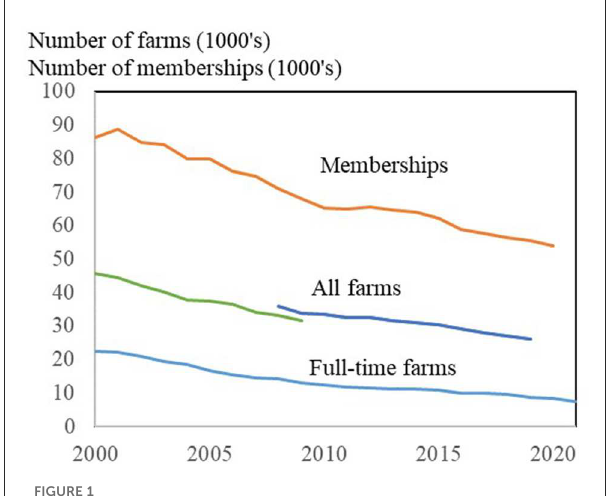
FIGURE1 Development of farms and farmer-cooperative memberships in